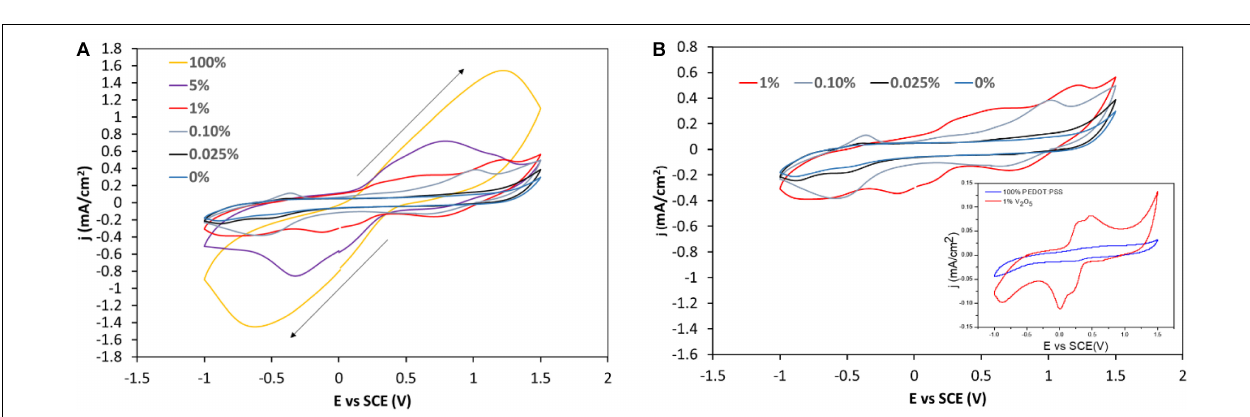
FIGURE 5 | (A) Cyclic Voltammograms (CVs) of various wt% hybrid films PEDOT:PSS-V 2 O 5 cycled in PEDOT:PSS-V 2 O 5 /Li-electrolyte/Pt vs. SCE using a 20 mV/s scan rate. (B) Zoom on the CVs of the film containing 1 wt% or less V 2 O 5 , inset CV of the 99%–1% PEDOT:PSS-V 2 O 5 with a thickness of 0.5 µ m.